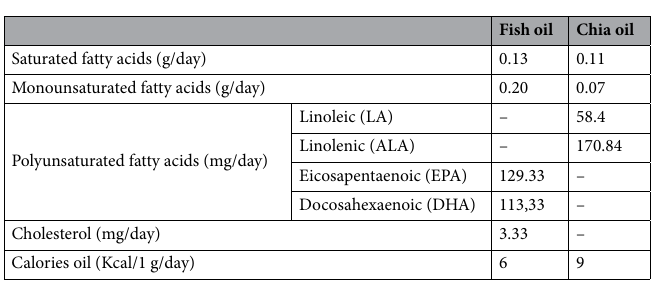
Table 3. Components of chia and fish